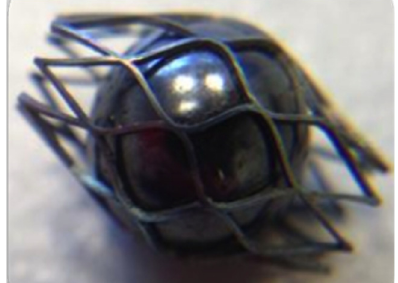
Figure 7. Expansion and shaping of the spherical occlusion device by inserting a steel ball.